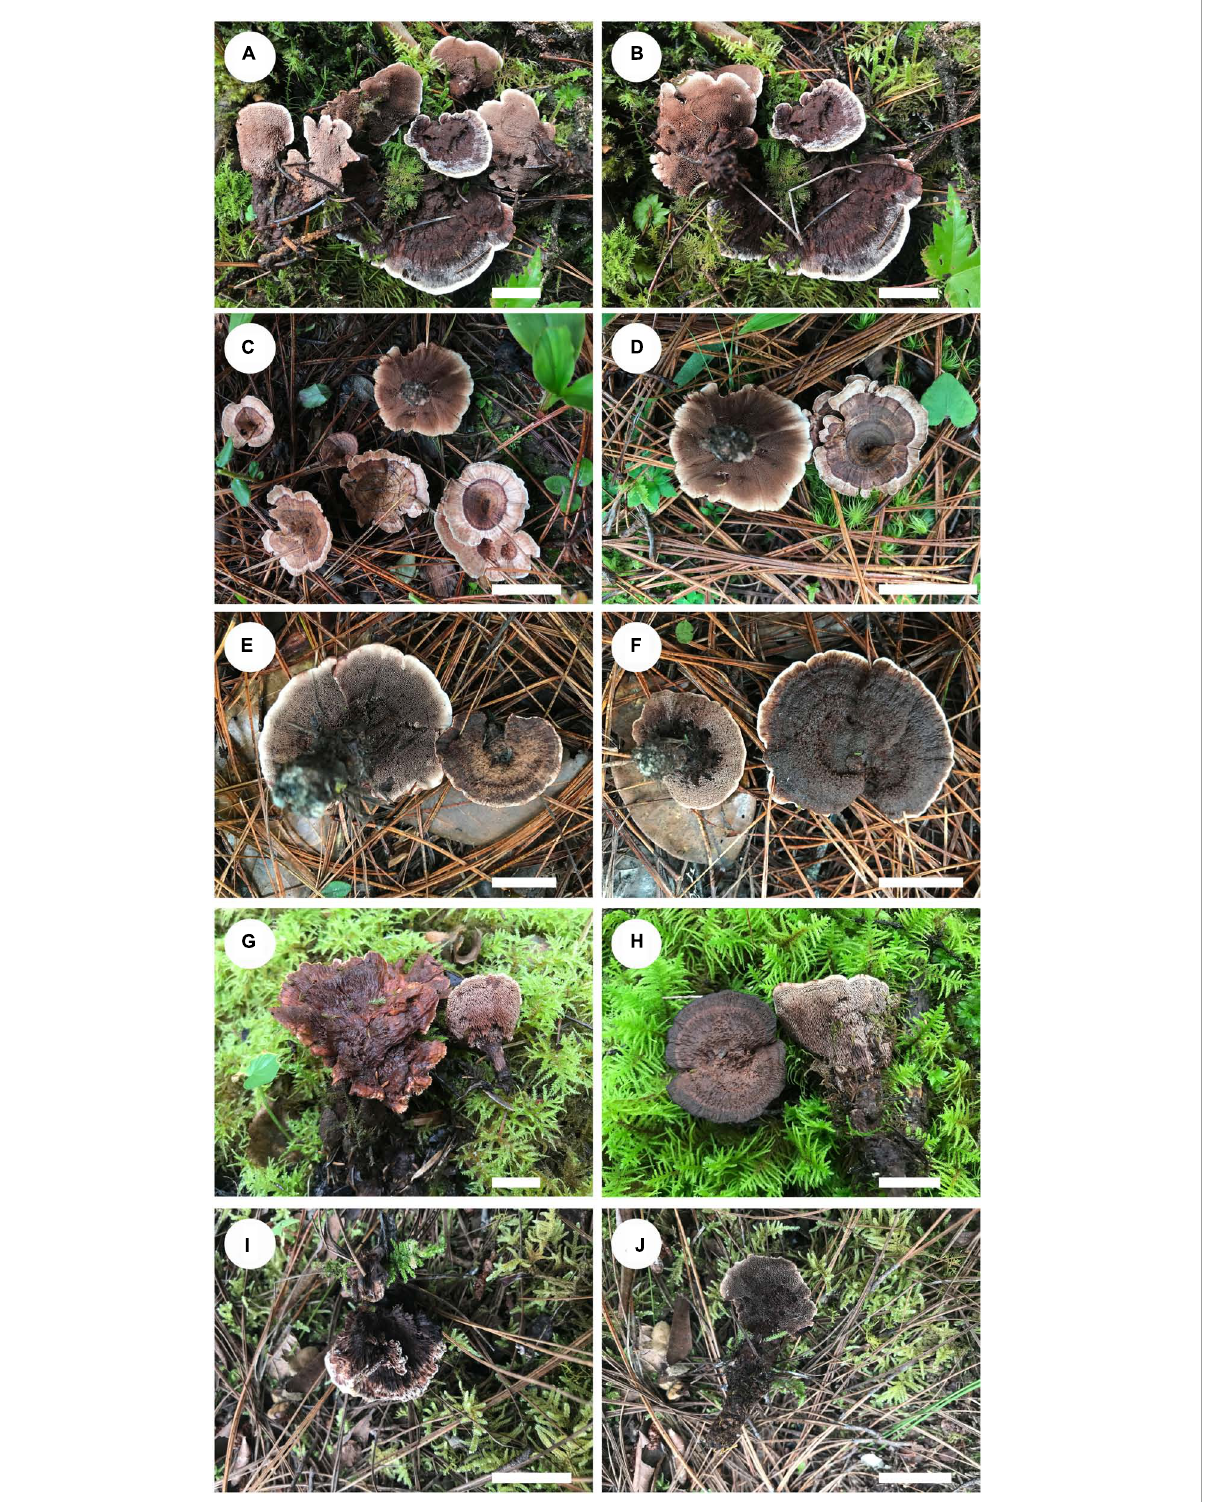
FIGURE3 Basidiomata of Hydnellum species. (A) H. chocolatum (paratype, Cui 18543), (B) H. chocolatum (holotype Cui 18545), (C,D) H. concentricum (holotype, Cui 17017), (E,F) H. crassipileatum (paratype, Cui 17019), (G) H. melanocarpum (paratype, Cui 18557), and (H) H. melanocarpum (paratype, Cui 18559), (I,J) H. radiatum (holotype, Cui 17130) Scale bars: 2